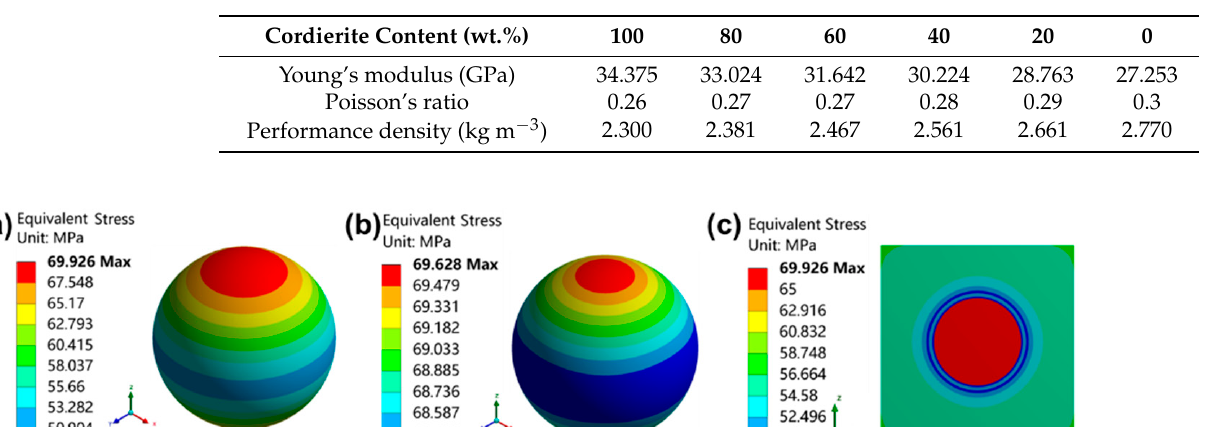
Figure 4. ( a ) Path I stress distribution curves for different mineral compositions; and ( b ) Average stress of the core, shell, with the entire model composed of different minerals. 3.1.2. Core–Shell Thickness Ratio The thickness ratio of core to shell is a key factor that affects not only the hydration process of CSLWA, but also the mechanical properties of CSLWA. In this section, 60% cordierite + 40% anorthite was kept fixed for the core; however, the thickness ratio C/S was varied, in relation to the following different values: 9:1, 8:2, and 7:3. Figure 5a shows the curves of stress distribution of core–shell LWAC with different thickness ratios along PATH I. The figure illustrates that, with the increase in the core–shell thickness ratio, the minimum stress value on the path changes location from the shell/cement matrix interface to the core/shell interface, and the stress difference on-shell also increases. A further anal- ysis of the average stress of each part of the model, shown in Figure 5b, indicates that the overall average stress of the model decreases slightly with an increase in the core–shell thickness ratio, whereas the stress on the core and shell almost remains unaltered. In other words, the core–shell thickness ratio does not affect the overall mechanical properties of the core–shell structure LWAC. However, an analysis of the stress distribution curves in- dicates that the increase in the core–shell thickness ratio leads to an increase in the stress difference on both sides of the shell, which increases the possibility of nucleation of mi- crocracks on the shell. Therefore, given that the shell is completely hydrated, reducing the core–shell thickness ratio of the CSLWA can lead to a more uniform stress distribution of LWAC.